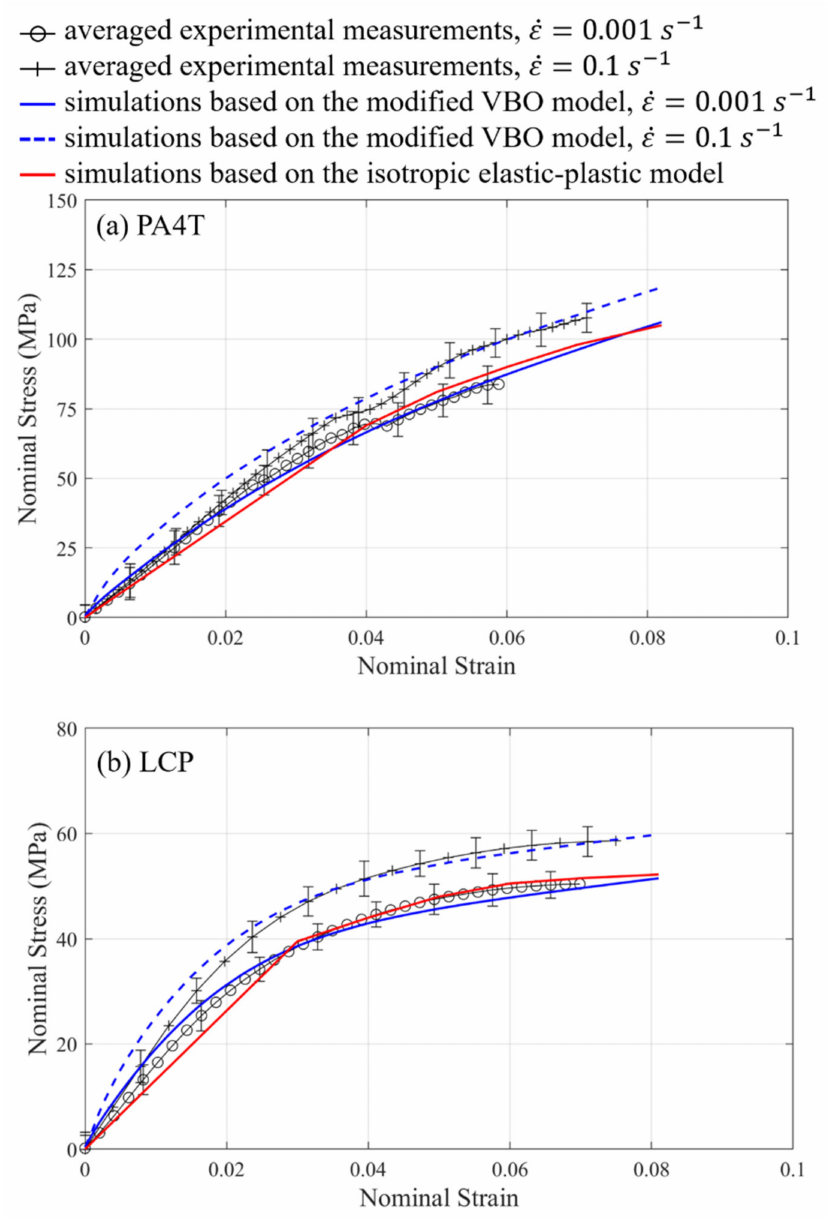
Figure 10. Stress-strain relationships of ( a ) PA4T ( b ) LCP under the uniaxial compression conditions based on the experiments and